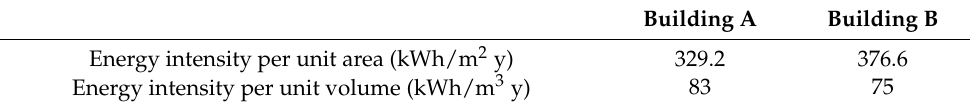
Table 2. Energy intensity per unit area and per unit volume for S1.